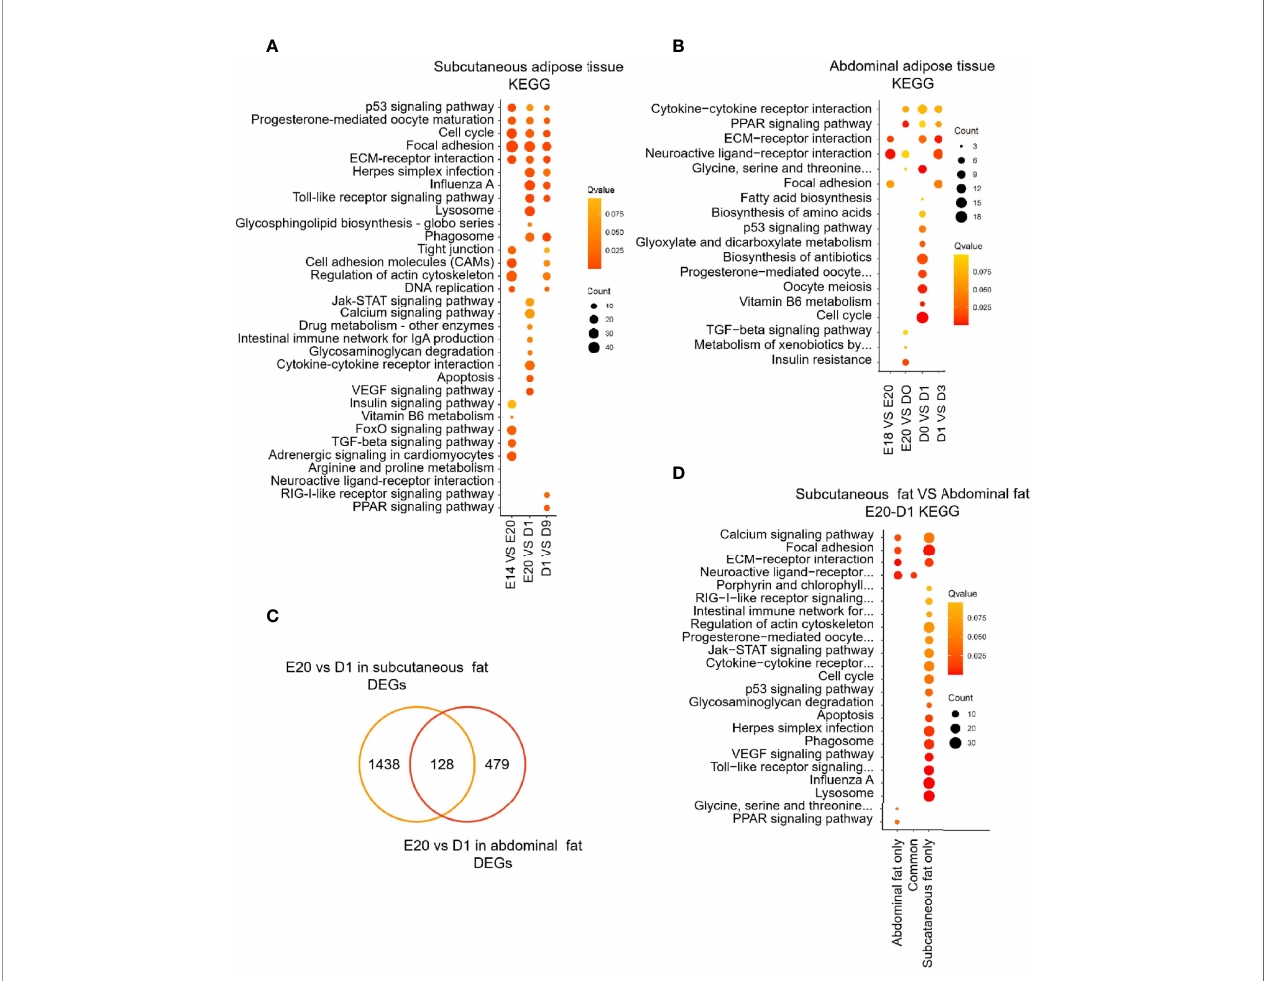
FIGURE 4 | KEGG enrichment of DEGs between different development stages in chick subcutaneous and abdominal adipose tissues. (A) KEGG enrichment of DEGs between different development stages in chick subcutaneous adipose tissue in four development stages; (B) KEGG enrichment of DEGs between different development stages in chick abdominal adipose tissue in fi ve development stages; (C) Venn analysis of DEGs between subcutaneous adipose tissue and abdominal adipose tissue (E20 vs. D1); (D) KEGG enrichment of Venn analysis of DEGs between subcutaneous adipose tissue and abdominal adipose tissue (E20 vs.